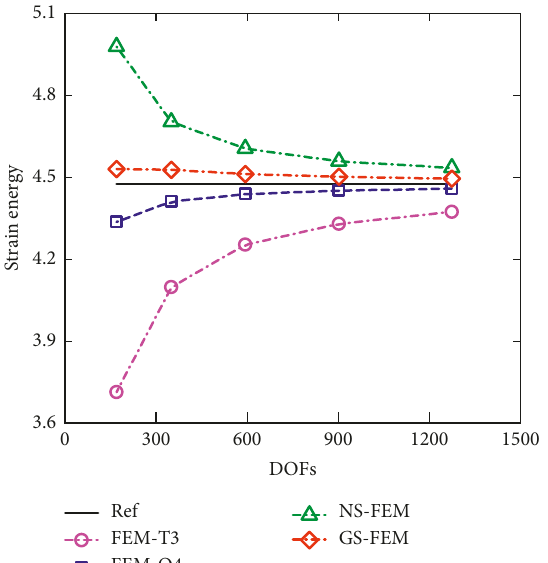
Figure 9: Energy error norm